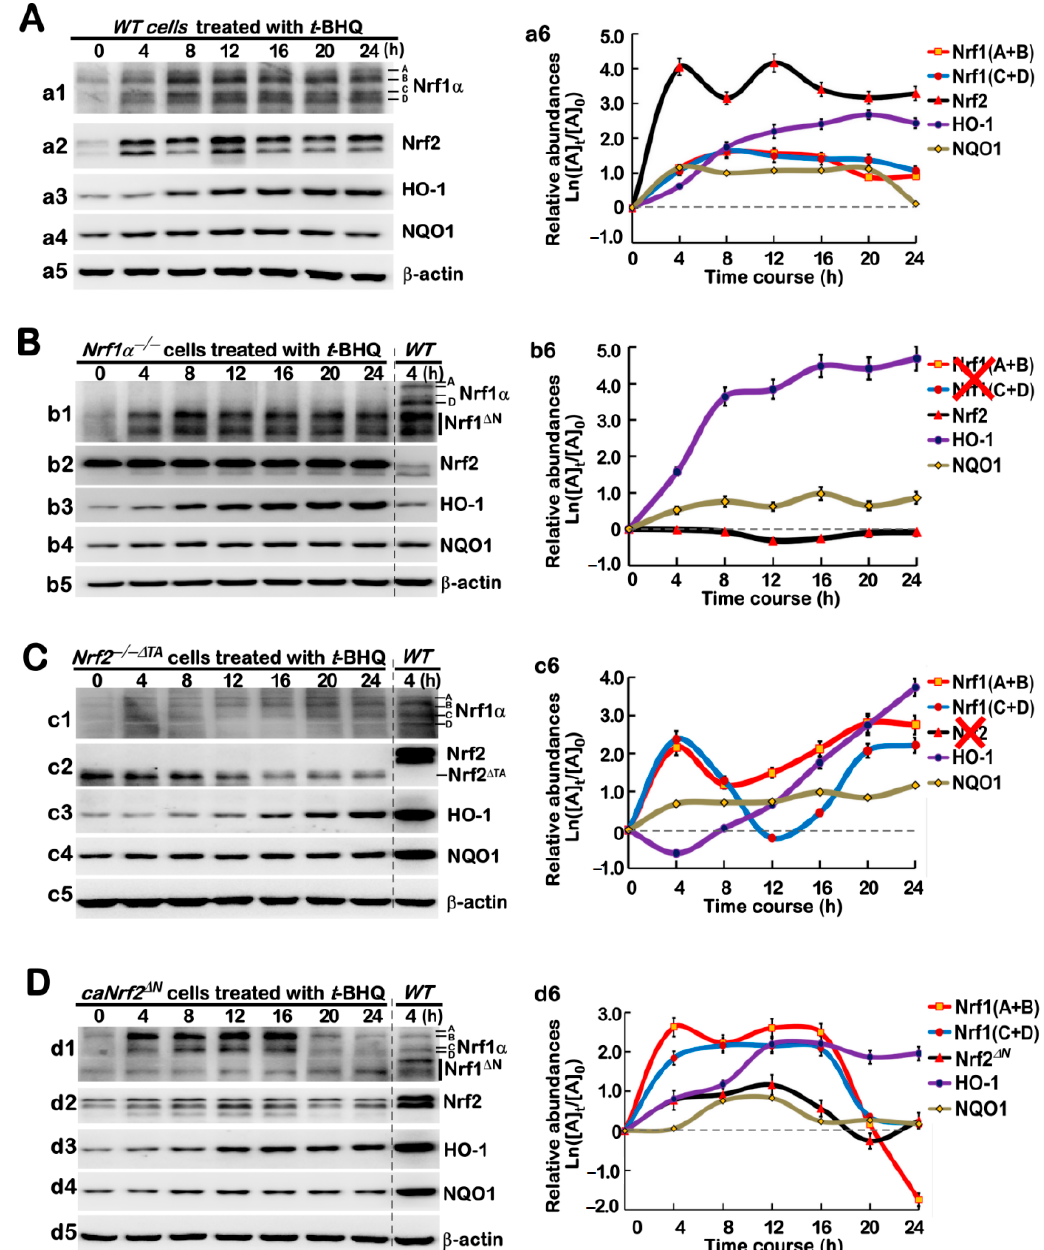
Figure 3. Long-term effects of t BHQ on protein abundances of Nrf1, Nrf2 and co-target genes. Experimental cells, WT ( A ), Nrf1 α − / − ( B ), Nrf2 − / − ∆ TA ( C ), and caNrf2 ∆ N ( D ), were or were not treated with 50 µ M t BHQ for 0 to 24 h, before basal and t BHQ-inducible protein changes of Nrf1 ( a1 , b1 , c1 , d1 ), Nrf2 ( a2 , b2 , c2 , d2 ), HO-1 ( a3 , b3 , c3 , d3 ), and NQO1 ( a4 , b4 , c4 , d4 ) were determined by Western blotting with their indicated antibodies, whilst β -actin served as a loading control. The intensity of those immunoblots, representing different protein expression levels, was also quantified by the Quantity One 4.5.2 software (Bio-Rad, Hercules, CA, USA). The data were representative of at least three independent experiments, as shown graphically (in right panels), after being calculated by a formula of Ln([A] t /[A] 0 , in which [A] t indicated a fold change (mean ± SD) in each of those examined protein expression levels at different times relative to the corresponding controls measured at 0 h (i.e., [A] 0 ). In addition, it should be noted that two big red crosses represent the constitutive losses of Nrf1 or Nrf2 ( b6 , c6 ),